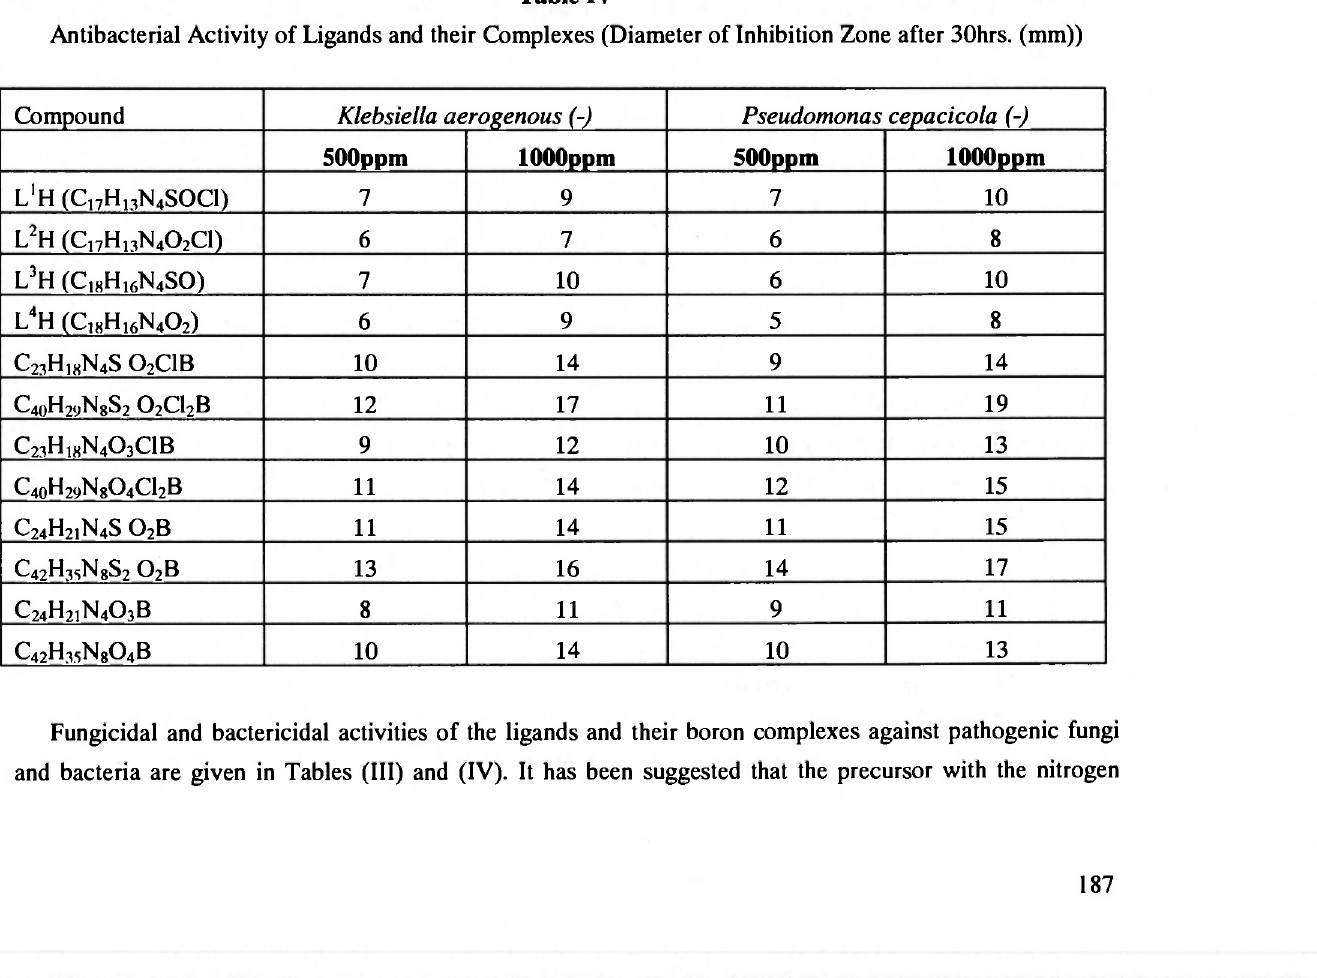
Fungicidal and bactericidal activities of the ligands and their boron complexes against pathogenic fungi and bacteria are given in Tables (III) and (IV). It has been suggested that the precursor with the